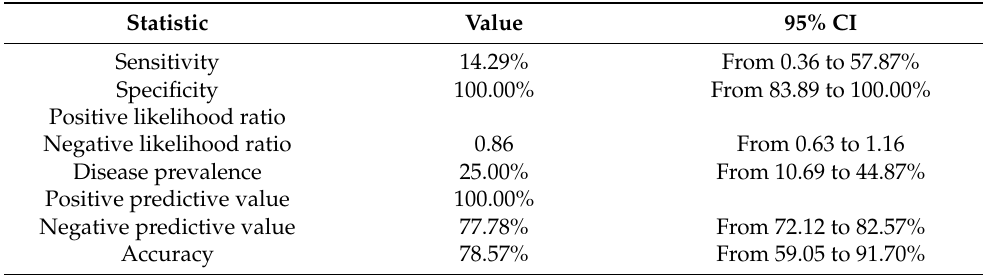
Table 5. Statistical analysis of preeclampsia prediction using the proposed LC-MS/MS method in 11th week of pregnancy. CI—confidence interval.